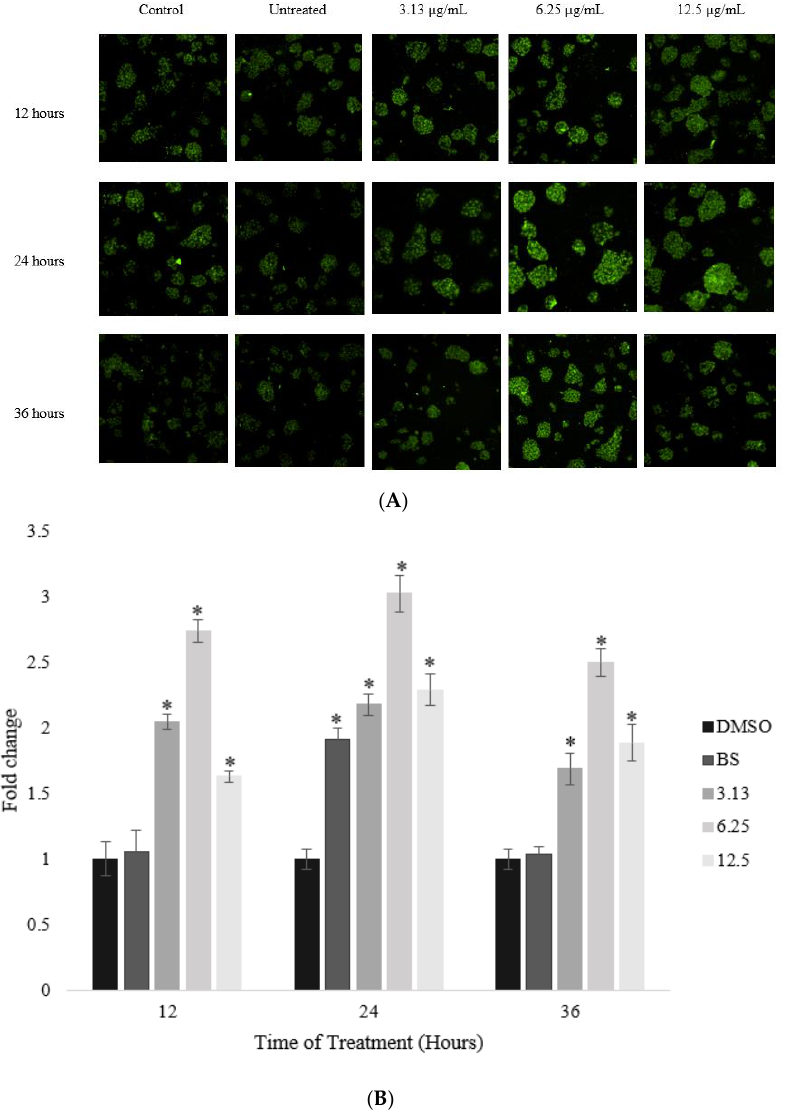
Figure 3. The effects of A. planci on the level of LDLR on the HepG2 cell line at 3 different time points: 12, 24, and 36 h, respectively. Cells were either untreated or treated with 3.13, 6.25, or 12.5 µg/mL of the selected fraction for 12, 24, and 36 h. Images were taken using a high-content screening platform (ImageXpress ® Micro, Molecular Devices) ( A ), and analyzed using ImageJ 1.52a; Java 1.8.0_191 ( B ). Berberine sulfate (BS)-treated cells were used as the positive control. ‘*’ denotes statistically significance ( p < 0.05) as compared to untreated control (DMSO). Next, in order to determine whether an increase in LDLR in the A. planci -treated cells also correspondingly produced an increase in LDL uptake, the cells were treated as pre- viously described and stained with LDL- DyLight™ 550 (Abcam, Cambridge, UK). As ex- pected, A. planci correspondingly produced a similar pattern of induction in LDL-C up- take in the HepG2 cells (Figure 4). The level of LDL-C present inside the cells significantly and steadily increased when the cells were treated with 3.13 µg/mL (1.5-, 1.7-, and 1.4-fold increases, respectively) and 6.25 µg/mL (1.87-, 2.0-, and 1.78-fold increases, respectively) of the selected fraction, and decreased at 12.5 µg/mL at 12, 24, and 36 h of treatment; how- ever, the level of LDL-C at 12.5 µg/mL was still higher than that for the control (1.79-, 1.87- , and 1.67-fold increases, respectively). Taken together, the results strongly indicate that the selected fraction of A. planci de- creased PCSK9 gene expression and, inversely, correspondingly increased the LDLR pro- tein level and elevated the LDL uptake in HepG2 cells.